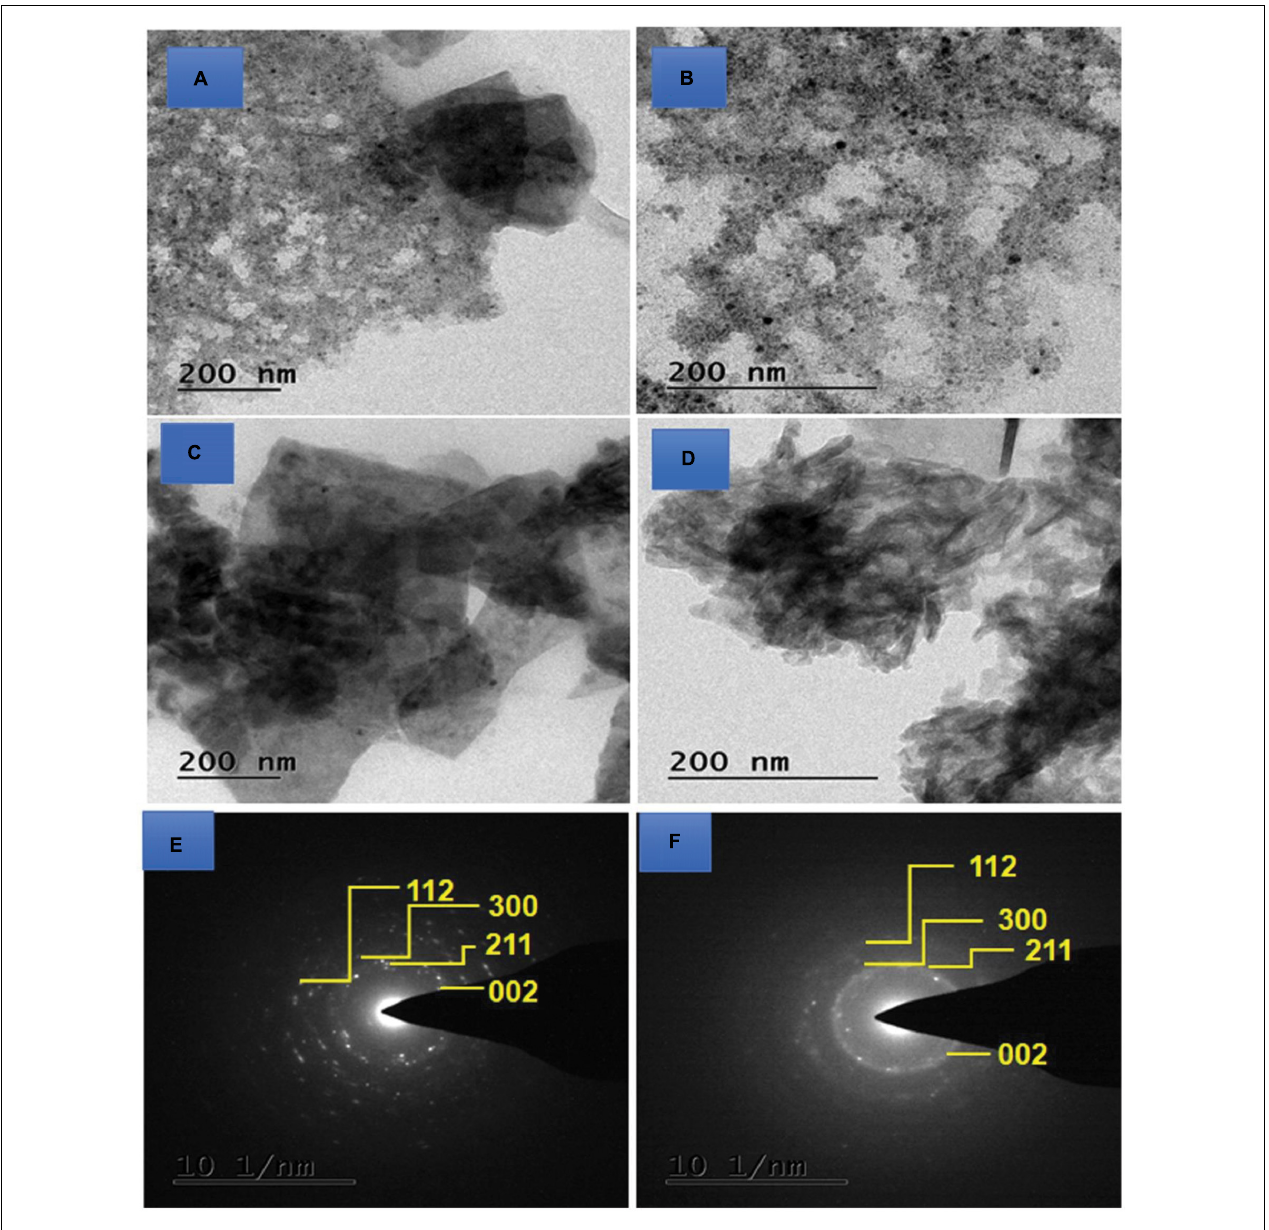
FIGURE 4 | TEM images of (A) HA, (B) BM-HA, (C) BM-HA/PAA, and (D) BM-HA/PAA/UMB composites and the SAED pattern of BM-HA/PAA (E) and BM-HA/PAA/UMB (F)